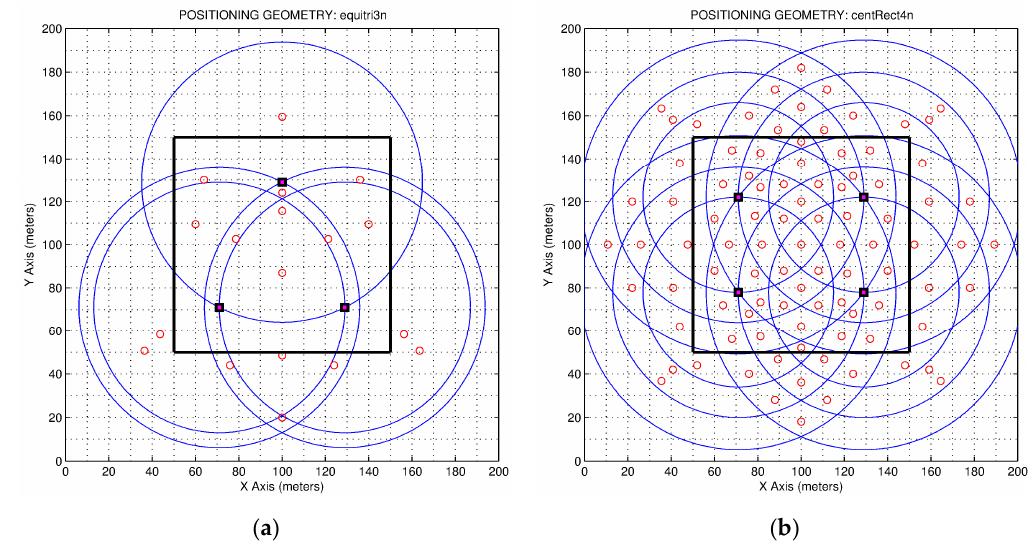
Figure 5. Centers of gravity (CoG) of the regions of two regionalization maps. ( a ) Triangular geometry of anchor positioning; ( b ) rectangular geometry of anchor positioning.